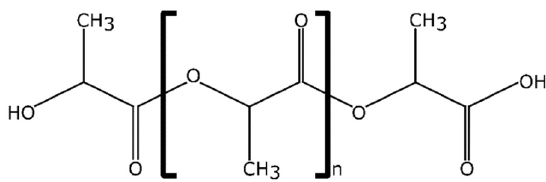
Figure 3. Structural formula of PLA. Table 3. Chemical composition of